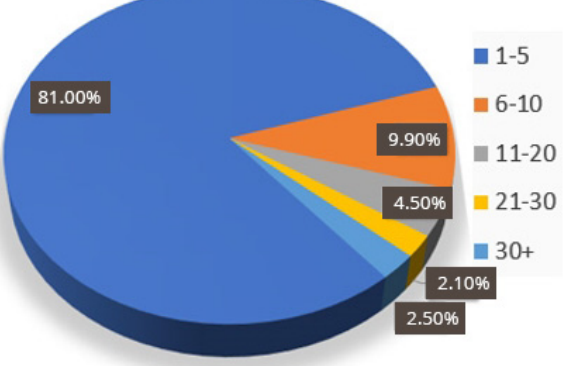
Figure 3. Frequency pie chart of number of employees.